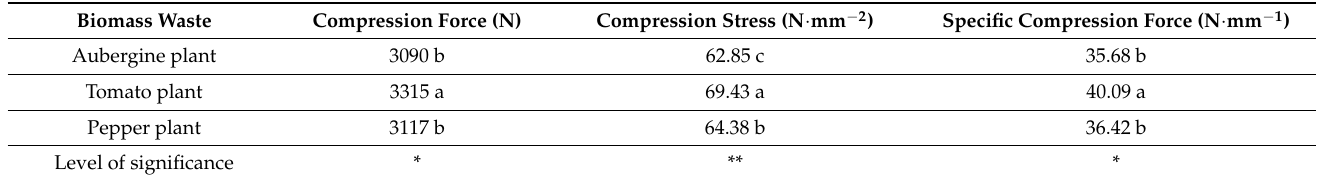
Table 5. Compression resistance and variance analysis results of obtained briquettes (on